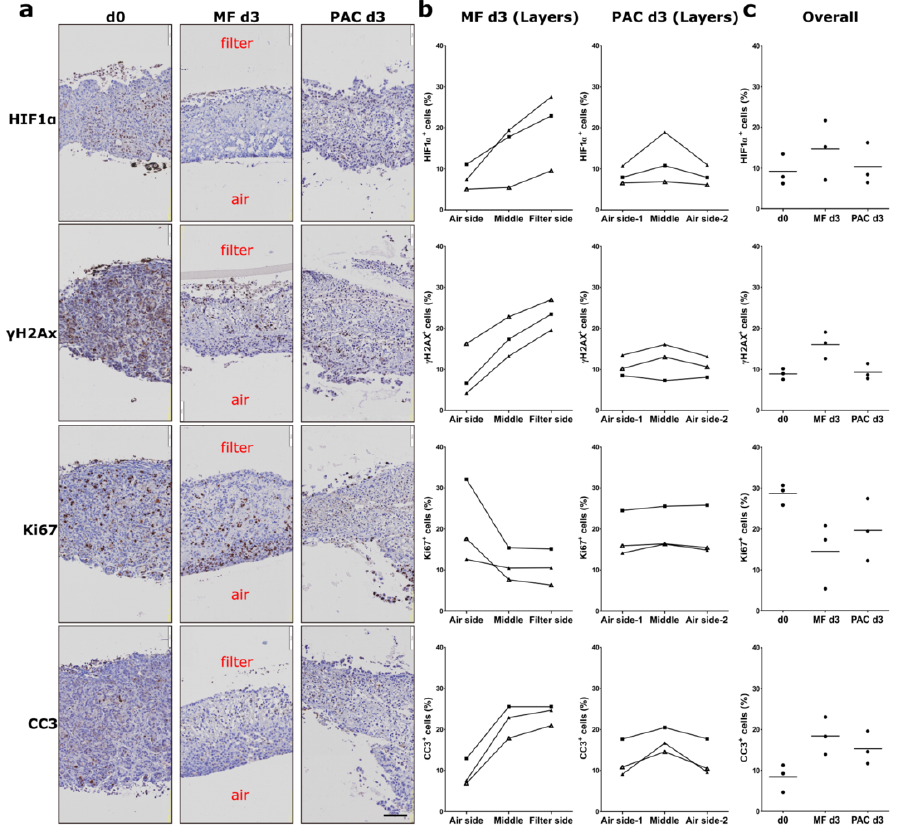
Figure 4. Expression of hypoxia-inducible factor 1 α (HIF1 α ), phospho-histone H2A.X ( γ H2AX), Ki67, and cleaved-caspase 3 (CC3) of H1437 CDX tumor slices in the Millipore filter (MF) culture system compared to the perfusion air culture (PAC) system. ( a ) Immunohistochemical (IHC) staining of biomarkers in H1437 CDX tumor slices after 3 days of cultivation either statically on Millipore filter (MF) or in the perfusion air culture (PAC) system with cotton meshes as organotypic support and compared to the day 0 (d0) non-cultivated tumor slices. Air indicates the air side; filter indicates the filter side of the MF culture system. Ki67, HIF1 α , and γ H2AX were stained to investigate proliferation, oxygen supply, and DNA damage. The scale bar represents 100 µm. ( b ) Quantification data of the percentage of cells expressing HIF1 α , γ H2AX, Ki67, or CC3 in different longitudinal layers of the tumor slices after culture in the MF or PAC systems. In the figures, each shape of the symbol represents one mouse experiment. Data shown are from experiments of three mice. ( c ) Quantification data of the overall percentage of cells in whole tumor slices expressing HIF1 α , γ H2AX, Ki67, and CC3 after culture in MF or PAC systems or in the in vivo tumors. Data shown are from experiments of three mice.